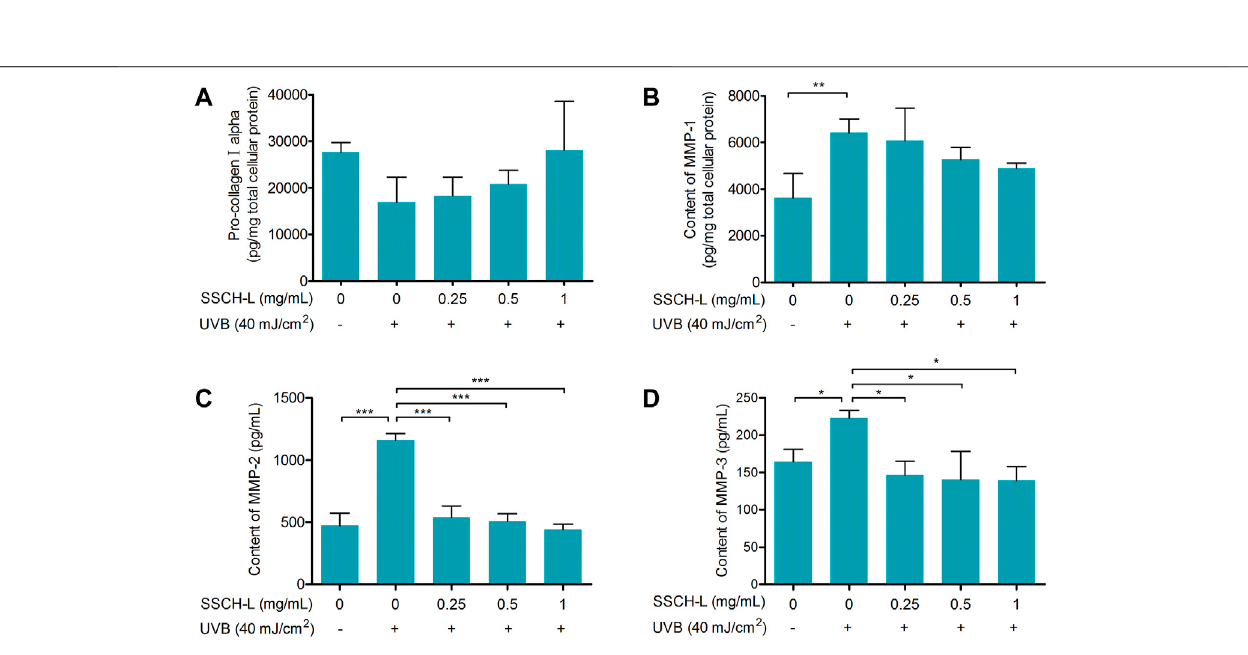
Frontiers in Bioengineering and Biotechnology |